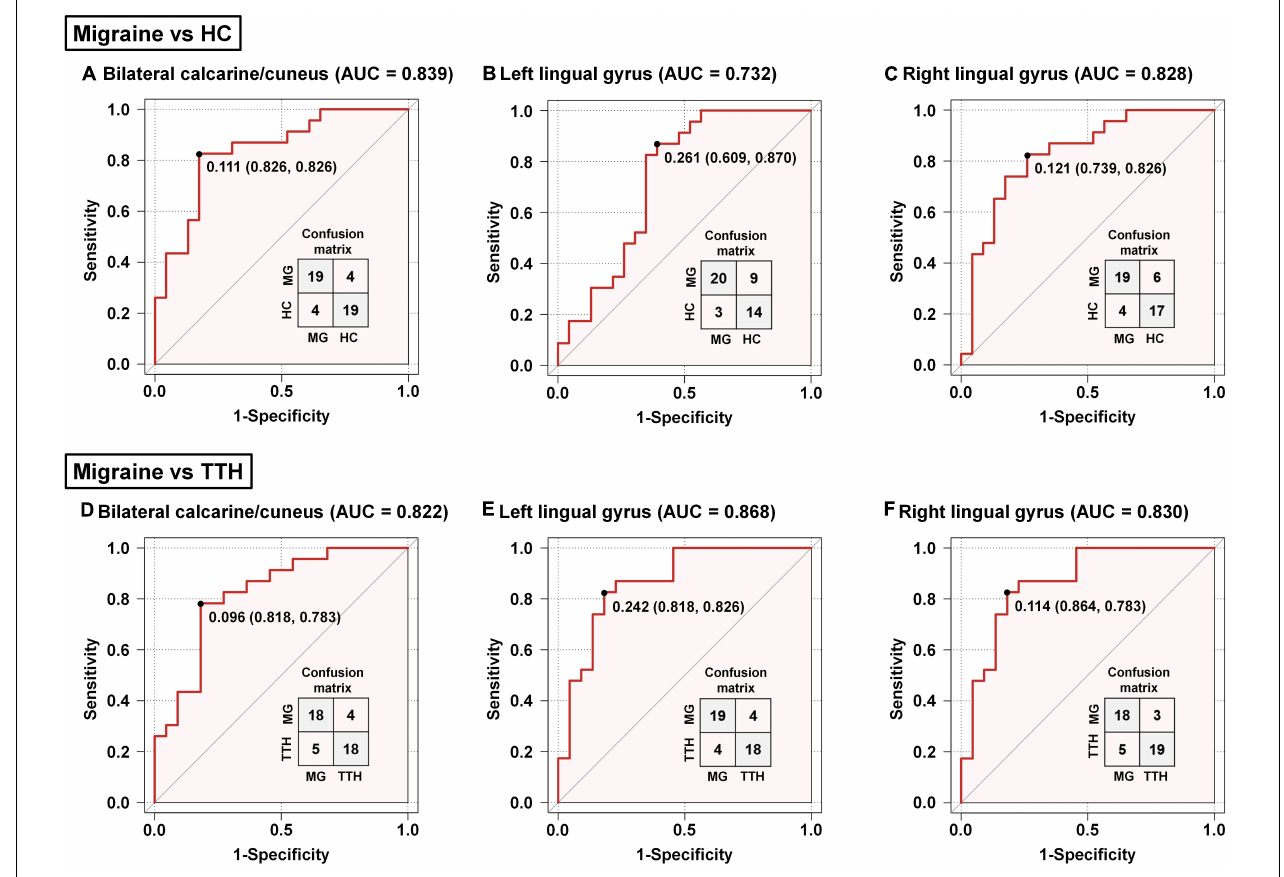
FIGURE 4 | Classification of migraineurs and non-migraineurs based on the rsFC alterations (seed: left amygdala). Classification of migraineurs and HCs (A–C) ; classification of migraineurs and patients with TTH (D–F) . The point on each ROC curve represents the optimal cut-off (specificity and sensitivity). MG, migraine; HC, healthy controls; TTH, tension-type headache; ROC, receiver operating characteristic; AUC, area under the curve.